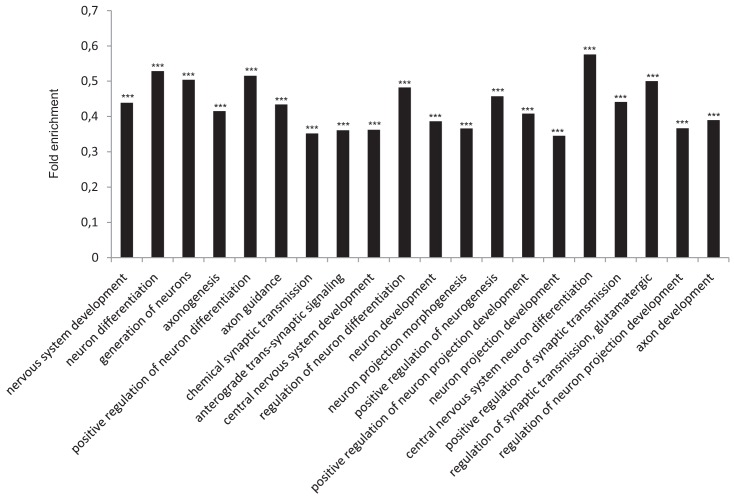
Functional annotation analysis of genes enriched in SUZ12 upon TRF1 depletion.(A) GO Biological process analysis of the genes associated with the genome sites were increased binding of SUZ12 protein was observed upon depletion of TRF1. Genes annotated in Clusters 1, 2 and 3 of the SUZ12 heatmap (Figure 2B) were used. Note that these genes are highly involved in processes related to the nervous system. *** = Adjusted p-value <0.0001.